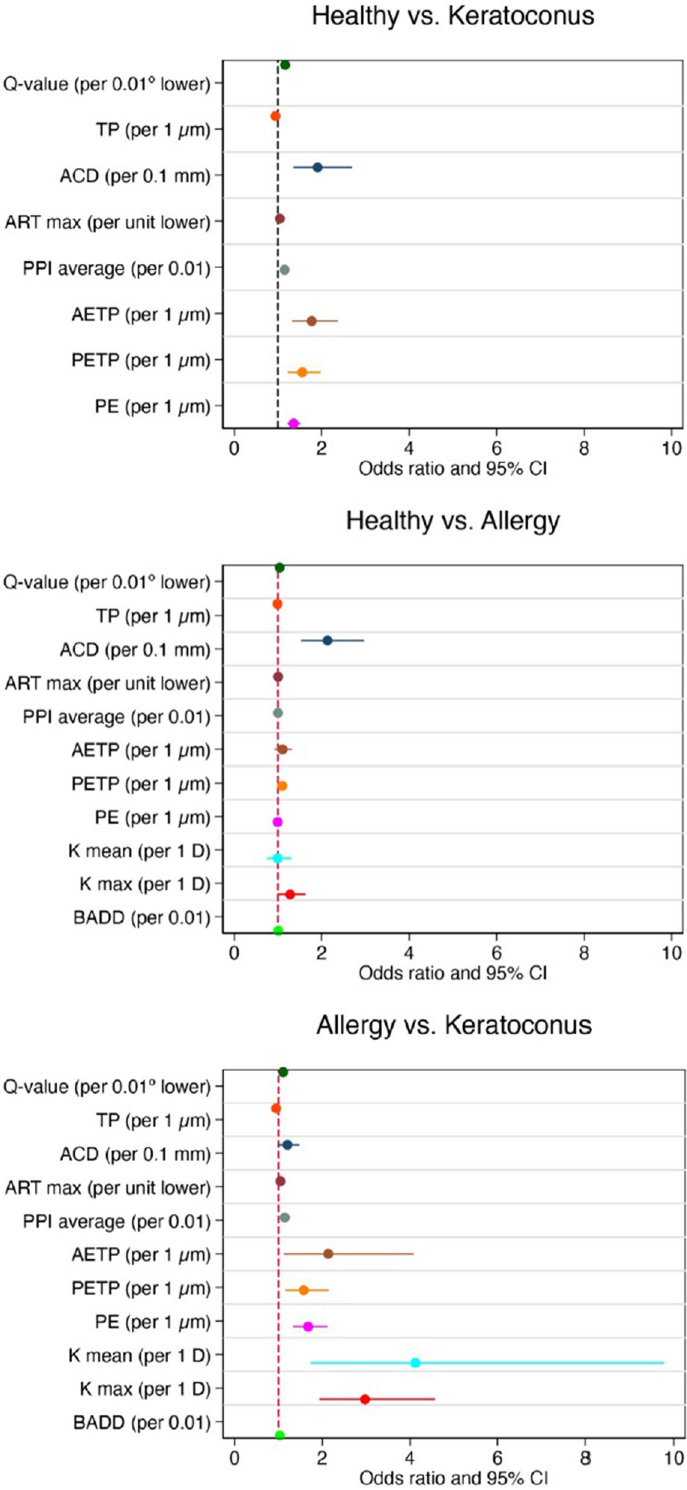
Figure 1. Forest plots for the odds ratio (OR) values and 95% confidence intervals from univariate models comparing ( A ) healthy controls to keratoconus patients, ( B ) healthy controls to ocular allergy patients, and ( C ) ocular allergy patients to keratoconus patients. Dashed vertical line represents an OR of 1. K1 flat keratometry, K2 steep keratometry, Kmax maximum keratometry, Astig astigmatism in Sim K, TP thinnest pachymetry, ACD anterior chamber depth, BAD-D Belin/Ambrosio’s Enhanced Ectasia Display, ARTmax Ambrosio’s relational thickness maximum, PPIave average pachymetric progression index, AETP anterior elevation at the thinnest point, PETP posterior elevation at the thinnest point, PE maximum posterior